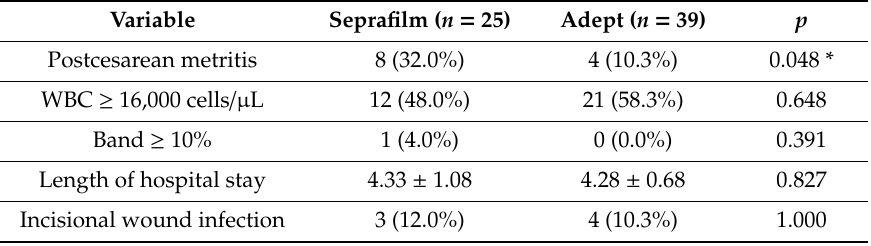
Table 4. Postcesarean metritis rate and laboratory data of contaminated and dirty wound, Seprafilm vs. Adept.